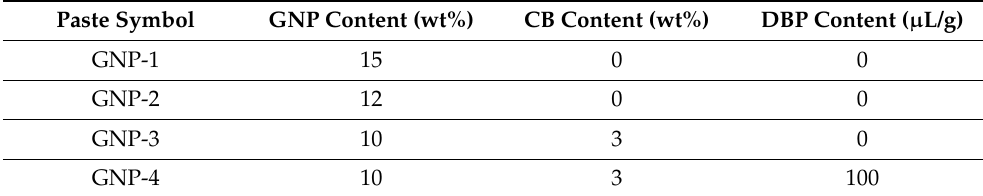
Table 1. Compositions of experimental pastes prepared for the study.